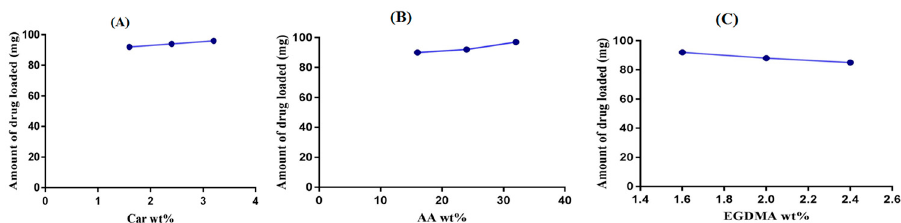
Figure 8. E ff ects of ( A ) carbopol, ( B ) AA and ( C ) EGDMA on the drug loading of the Car934-g -poly(acrylic acid)